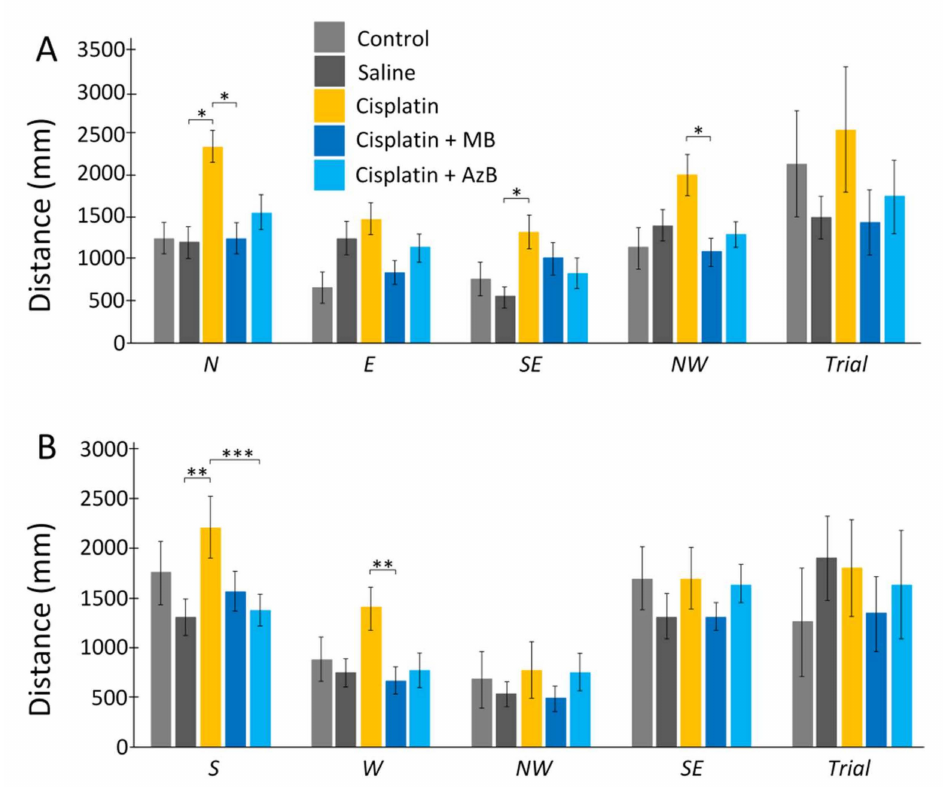
Figure 2. The Morris water maze. Distance in the ( A ) acquisition, ( B ) reversal learning. The results expressed as means ± SEM. Control n = 4, Saline = 7, Cisplatin = 6, Cisplatin+ MB = 8, Cisplatin+ AzB = 8. * p < 0.05, ** p < 0.01, *** p < 0.001, groups were compared using the U